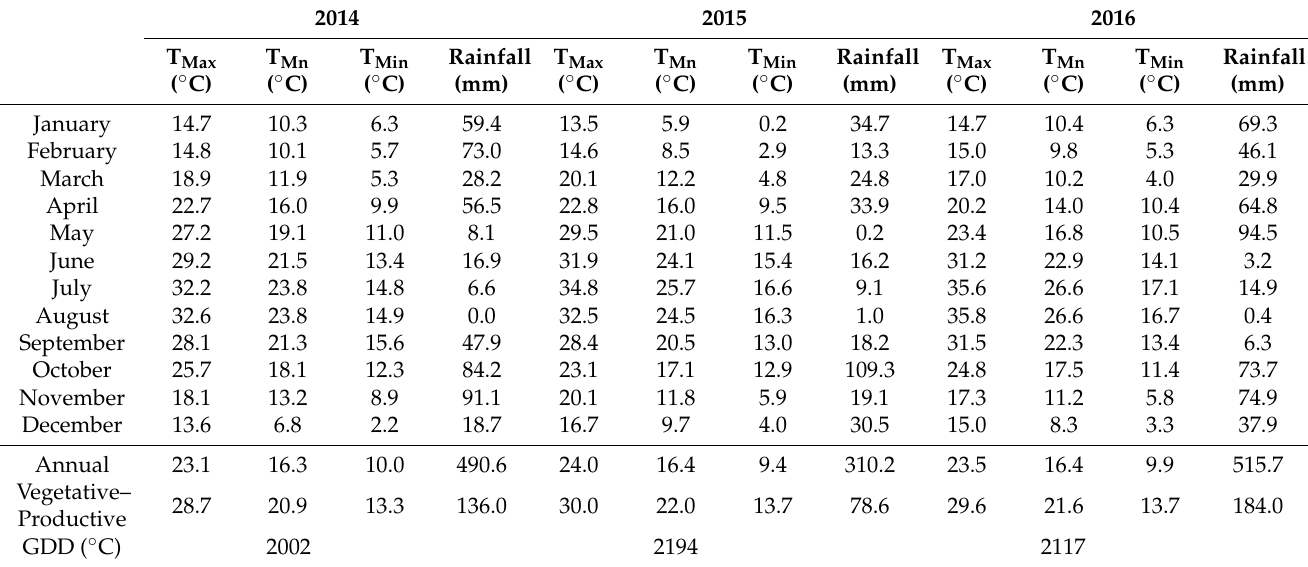
Table 1. Yearly meteorological data of the experimental site in western Spain (Badajoz) from 2014 to 2016. T Max : maximum temperature; T Mn : mean temperature; T min : minimum temperature; GDD: growing degree day (base 10 ◦